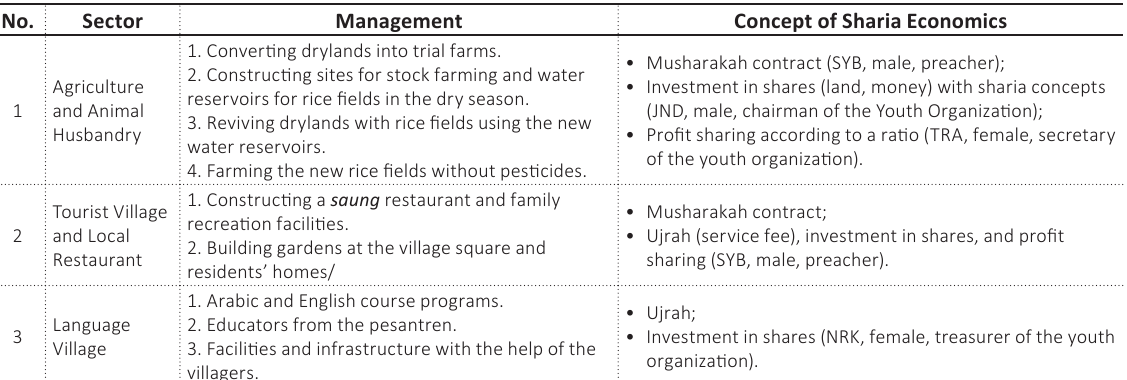
Table 3. Implementation of sharia economics in Gerdu Village